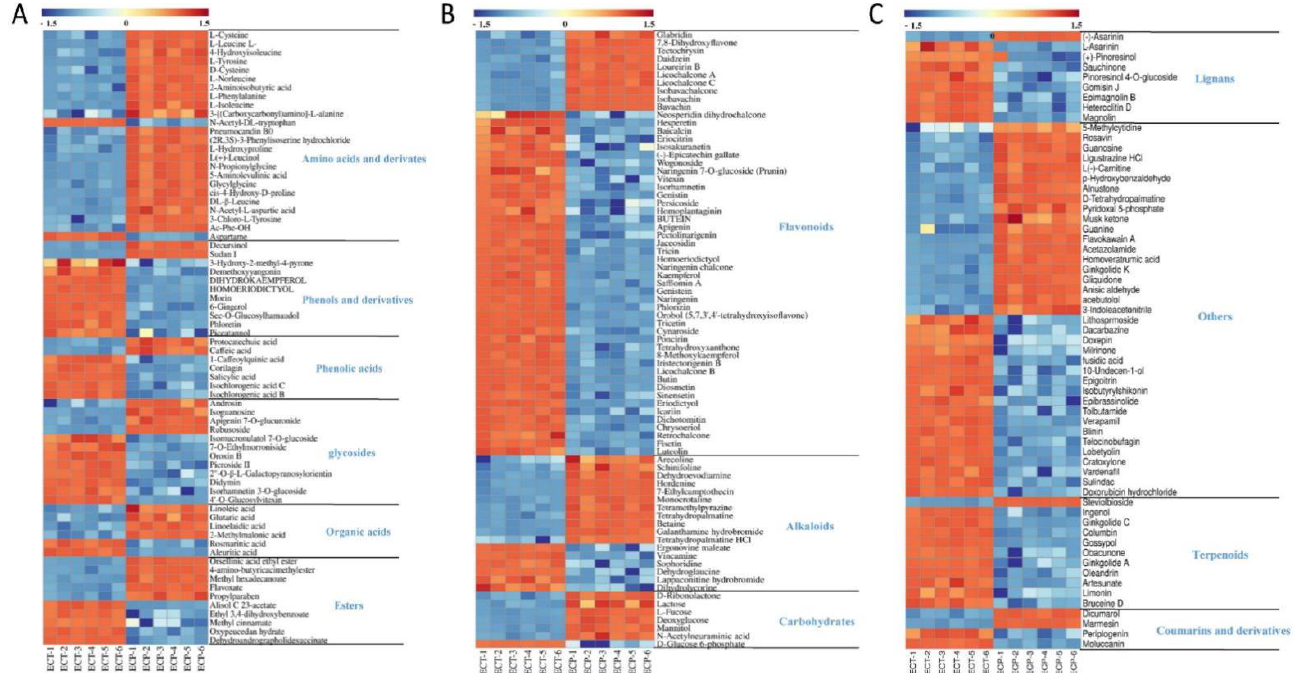
Figure 3. ( A ) Heat map of amino acids and derivates, phenols and derivatives, phenolic acids, glycosides, organic acids and esters in ECT and ECP; ( B ) Heat map of flavonoids, alkaloids and carbohydrates in ECT and ECP; ( C ) Heat map of lignans, coumarins and derivatives, terpenoids and other differential metabolites in ECT and